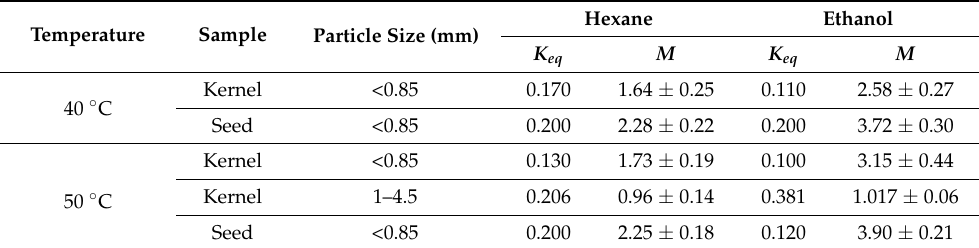
Table 2. Equilibrium properties of the extraction process.